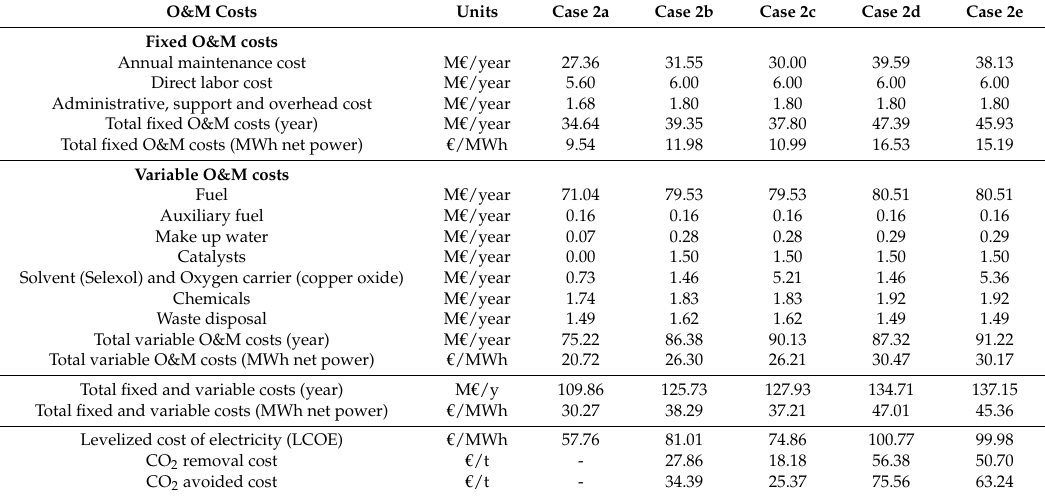
Table 6. Operation and maintenance (O&M) costs, CO 2 capture costs and levelized cost of electricity for IGCC power